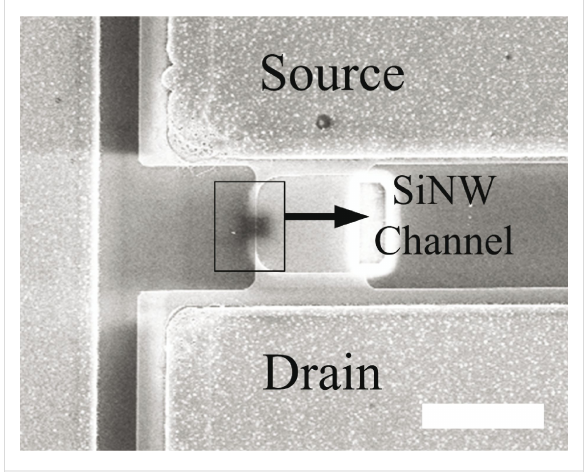
Figure 5: SEM image of the SiNW FET device. The scale bar is 20 µm.